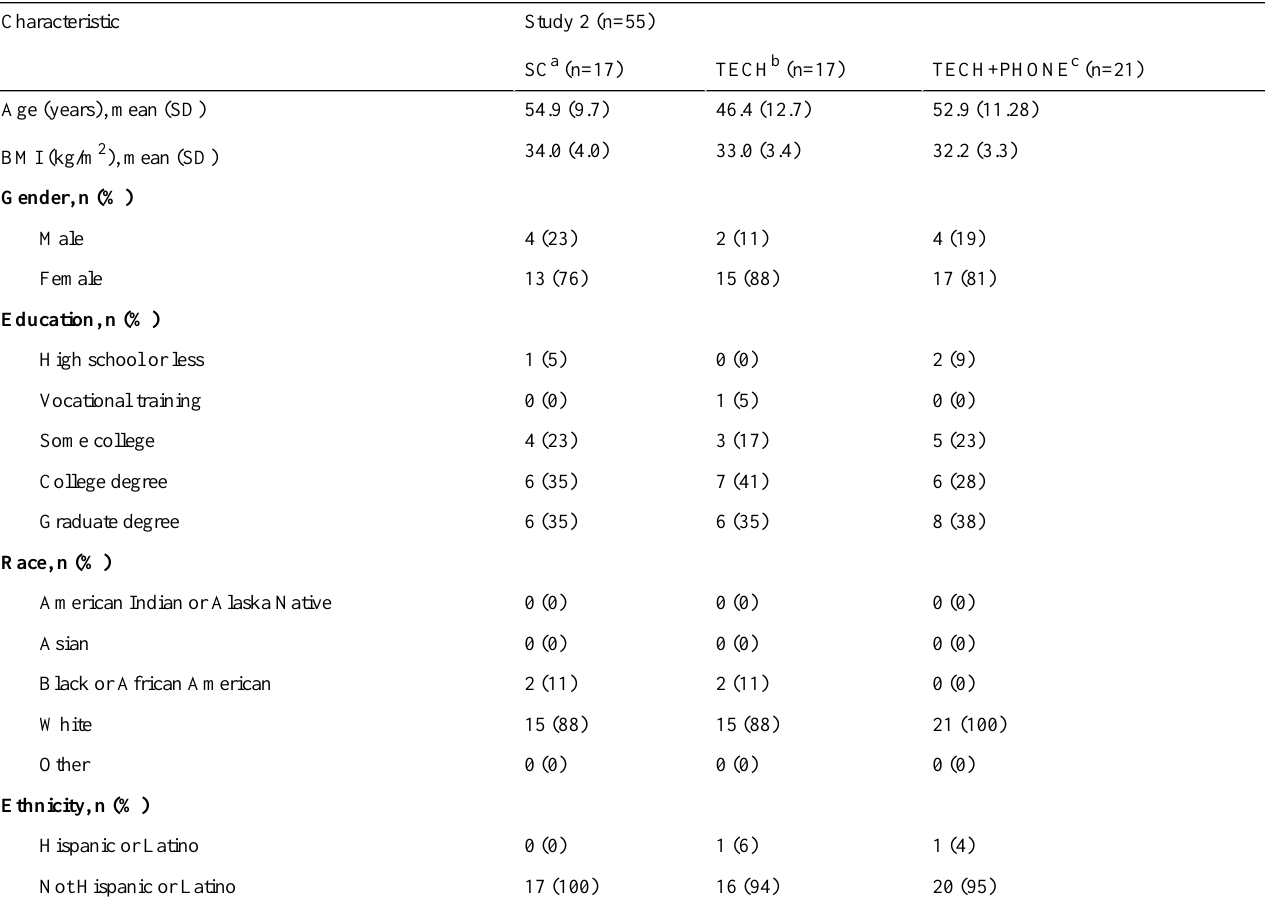
Table 3. Baseline and demographic characteristics of participants by group in study 2.